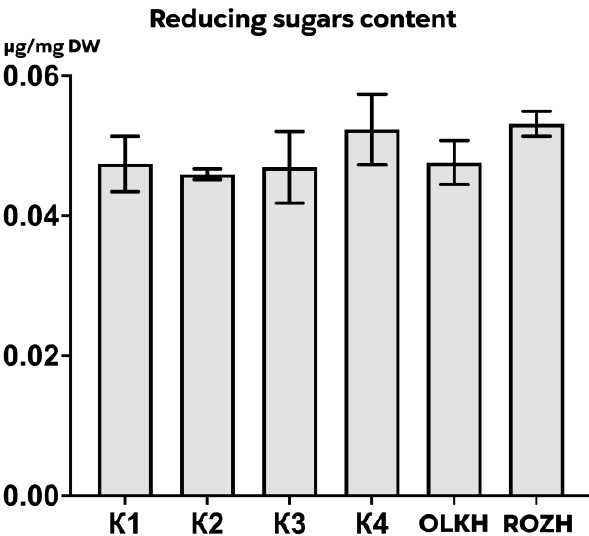
Figure 10. Reducing sugar content in tubers of H. tuberosus growing in contaminated areas and in areas without contamination.